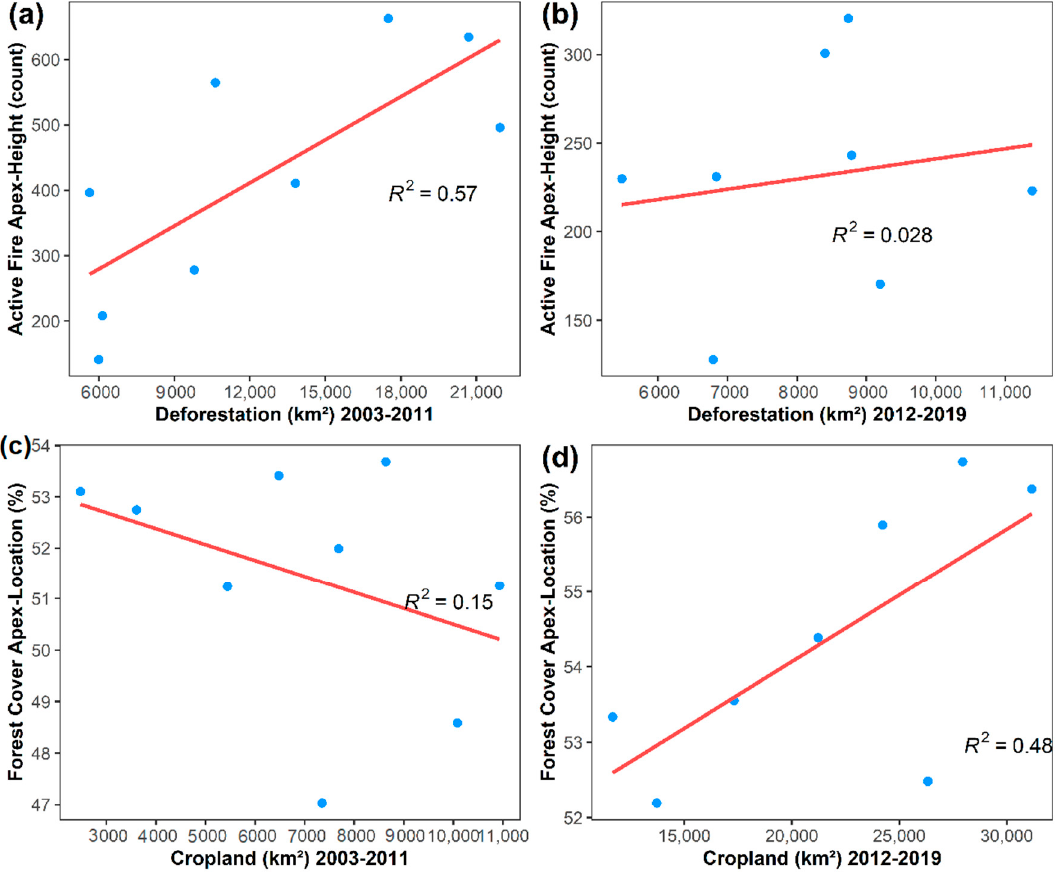
Figure A6. Linear models of the significant variables used to describe active fire apex-height and forest cover apex-location per analysed period. ( a ) Active fire height by annual deforestation from 2003 to 2011. ( b ) Active fire height by annual deforestation from 2012 to 2019. ( c ) Location of the active fire apex in relation to forest cover against cropland area from 2003 to 2011. ( d ) Location of the active fire apex in relation to forest cover against cropland area from 2012 to 2019.